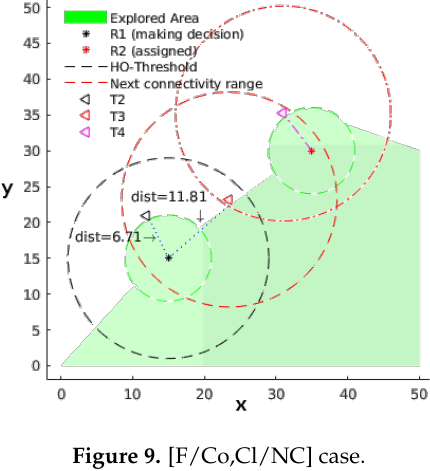
Figure 9. [F/Co,Cl/NC]